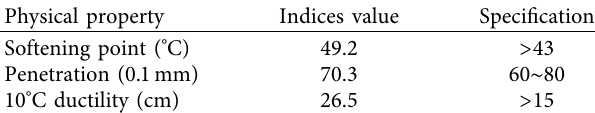
Table 1: Physical property of 70#